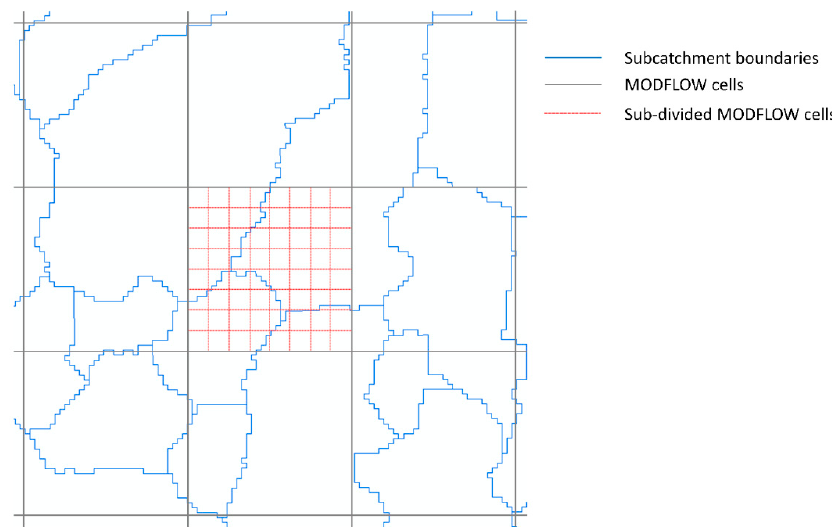
Figure 2. An illustration of the overlapping of subcatchment boundaries, original MODFLOW cells and fine-resolution subdivisions of the MODFLOW cells, taken from part of the Hauraki case study catchment.